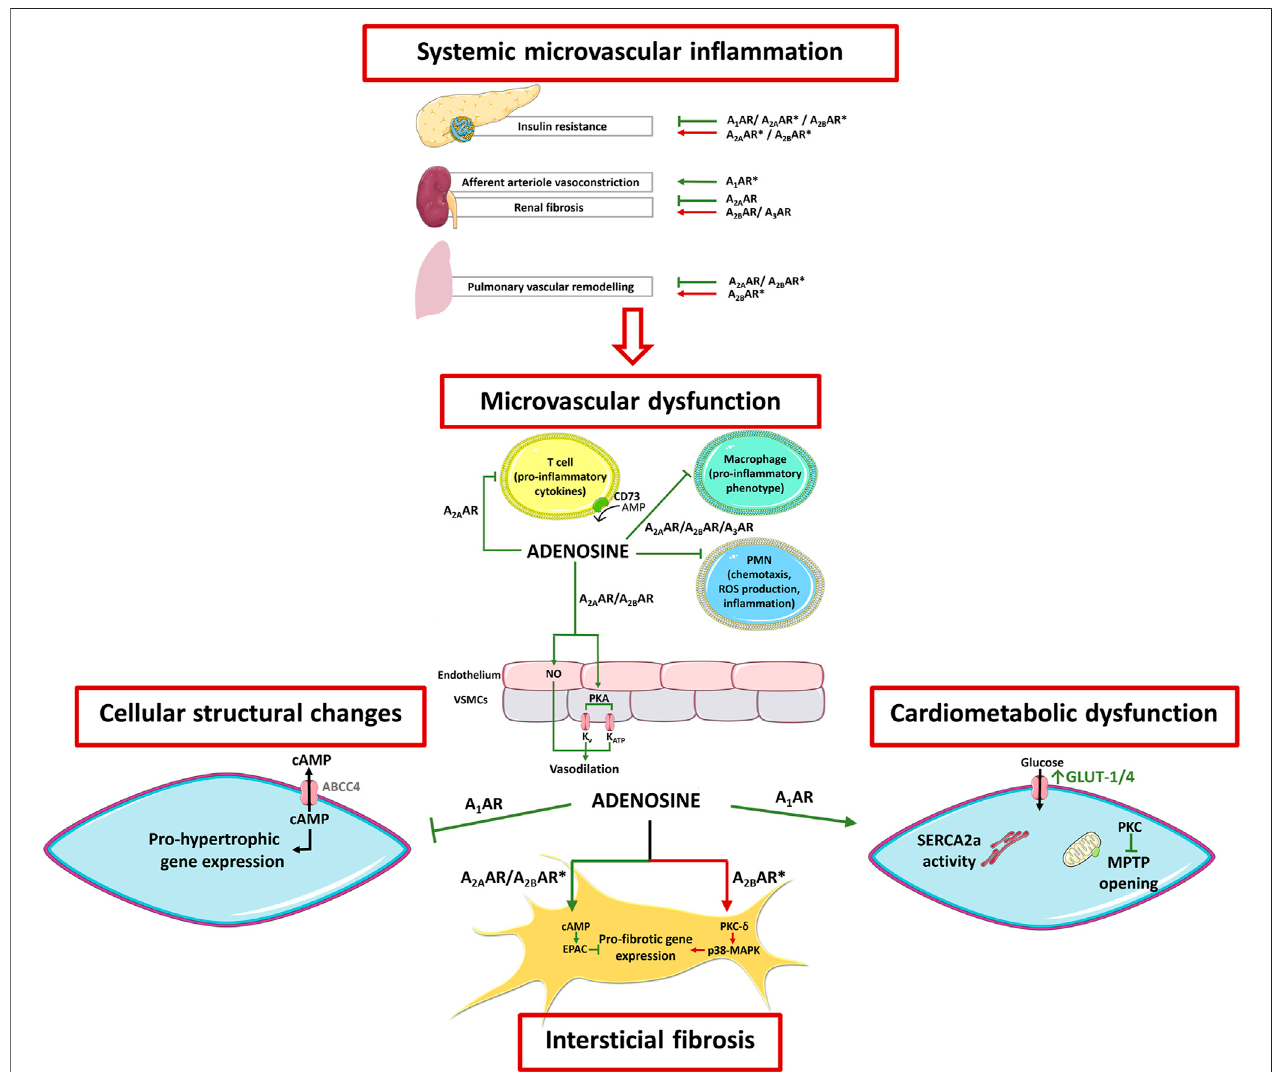
FIGURE 3 | Schematic representation of adenosine receptors involvement in HFpEF pathophysiology. HFpEF is a complex clinical syndrome where comorbidities-induced systemic in fl ammation predispose and perpetuate microvascular dysfunction, as well cardiac structural and metabolic abnormalities. Overall, adenosine counteracts most of the pathophysiological features of this syndrome. These include 1) cardiac in fl ammation and microvascular dysfunction (via A 2 AR activation), 2) myocardial structural abnormalities (via A 2 AR and A 1 AR activation), and 3) energy metabolism and calcium handling (via A 1 AR activation). Con fl icting evidence, however, exist regarding A 2B AR-mediated cardioprotection, as this receptor has been implicated in both pro- and anti- fi brotic effects in the heart and lungs. Adenosine receptors also play important roles in cardiometabolic comorbidities related to HFpEF. Activation of A 1 AR improves the metabolic pro fi le and induces renal afferentarteriolevasoconstriction,whichcanbeprotectivewhenpreservationoftheglomerulararchitectureandfunctionisneeded.StimulationofA 2A ARandtheA 2B AR reduce lipolysis, but this bene fi cial effect may be partially counteracted by their action on skeletal muscles that contribute to insulin resistance. Activation of A 2A AR counteracts renal damage due to its ability to reduce fi brosis, independently of A 3 AR and A 2B AR are active or not. The arrows and bars indicate the effects induced or blockedbyadenosinereceptoractivation,respectively.Green (cid:1) bene fi cialeffect;Red (cid:1) deleteriouseffect;Asterisk(*) (cid:1) contradictory/con fl ictingdata.AdaptedfromLam et al.,2018andHeadricketal.,2013.Illustration usedelements fromServierMedicalArt(http://smart.servier.com)ABCC4, ATP-binding cassette sub-familyCmember 4; AR, Adenosine receptor; cAMP, cyclic adenosine monophosphate; EPAC, Exchange factor directly activated by cAMP; FFA, Free fatty acid; GLUT, Glucose transporter;MAPK,Mitogenactivatedproteinkinase;MPTP,Mitochondrialpermeabilitytransitionpores;NO,Nitricoxide;PKA,ProteinkinaseA;PKC,ProteinkinaseC; PMN, Polymorphonuclear leukocytes; SERCA2a, Sarco/endoplasmic reticulum Ca 2+ -ATPase 2a; a -SMA, Alpha-smooth muscle actin; VSMC, Vascular smooth muscle